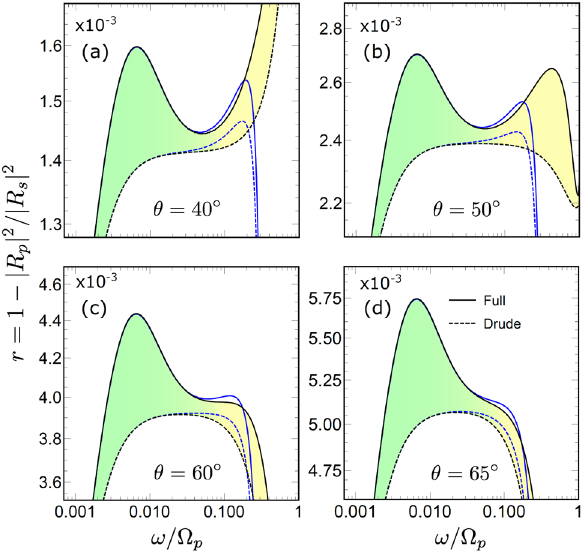
2 / 2 1 R p R s Figure 6. Reflectivities ratio r subtracted from unity for p and s polarizations, for θ = − | | | | 50 60 65 (a), θ ◦ (b), θ = ◦ (c) and θ = ◦ (d). Results for the full LRS model (solid line ”Full”) are compared = with the Drude approximation (dashed line ”Drude”). Blue lines give the results calculated with the interband transitions, solid and dashed lines represent the full and Drude models, respectively.